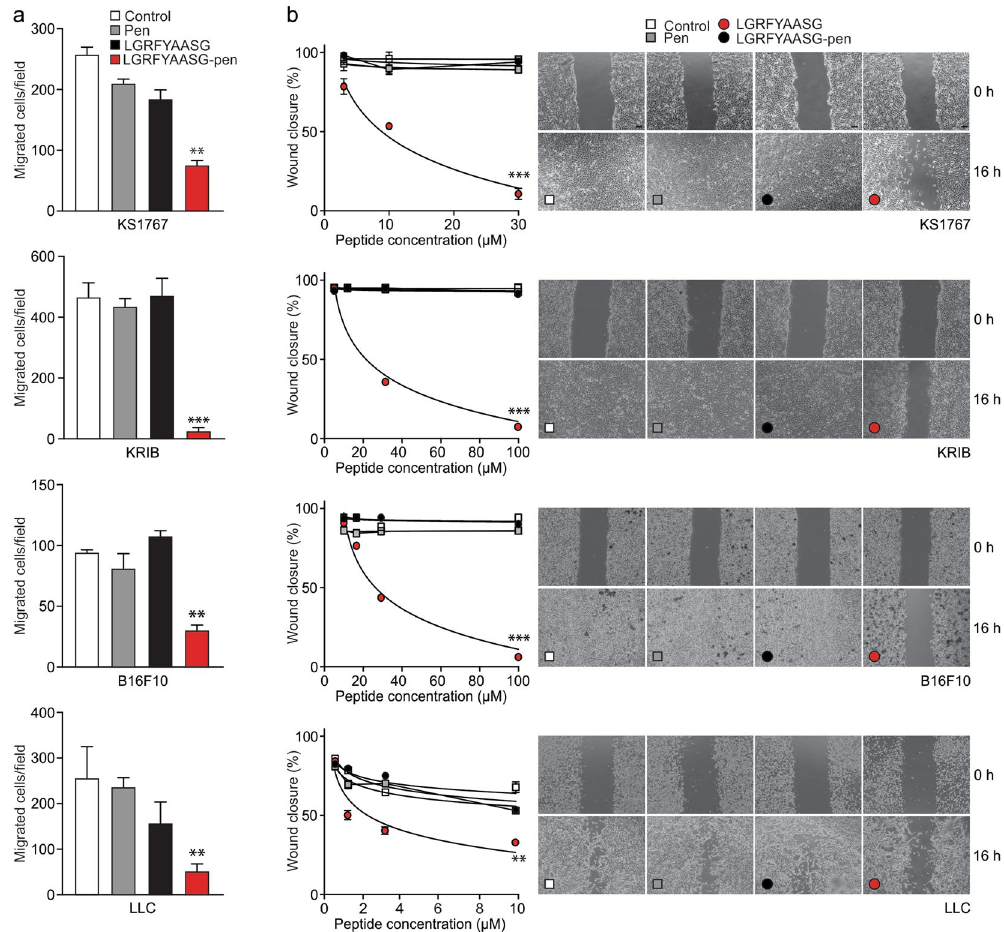
Figure 4. LGRFYAASG-pen inhibits tumor cell migration. ( a ) Transwell cell migration assays: 10 5 cells were applied to the upper chamber of transwell inserts in the presence of each peptide (100 µ M for KS1767, KRIB, B16F10, 10 µ M for LCC). After 24 h, migrated cells were fixed, stained in crystal violet and counted (5 fields/ well) under a light microscope ( ** P < 0.001; *** P < 0.0001 versus the control experimental points). ( b ) Wound- healing cell motility assays performed with KS1767, KRIB, LLC and B16F10 cells. A wound was produced with a pipetman tip in confluent cell layers, followed by incubation with either medium only or the indicated peptides (3–30 μ M for KS1767, 10–100 μ M for KRIB and B16F10, 1–10 μ M for LLC). The width of the wounds was imaged with a phase-contrast microscope, and is represented as percent of wound closure. Micrographs refer to the highest peptide concentrations. Scale bar, 100 µ m. ( ** P < 0.001; *** P < 0.0001 versus control experimental